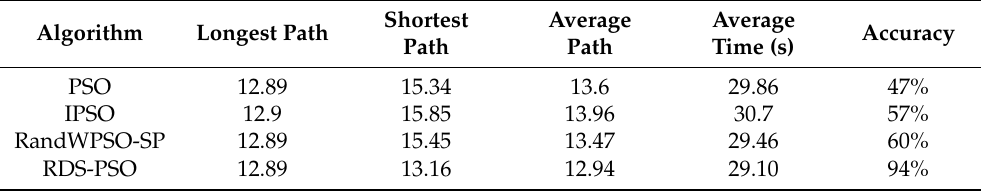
Table 1. Comparison of algorithm performance.